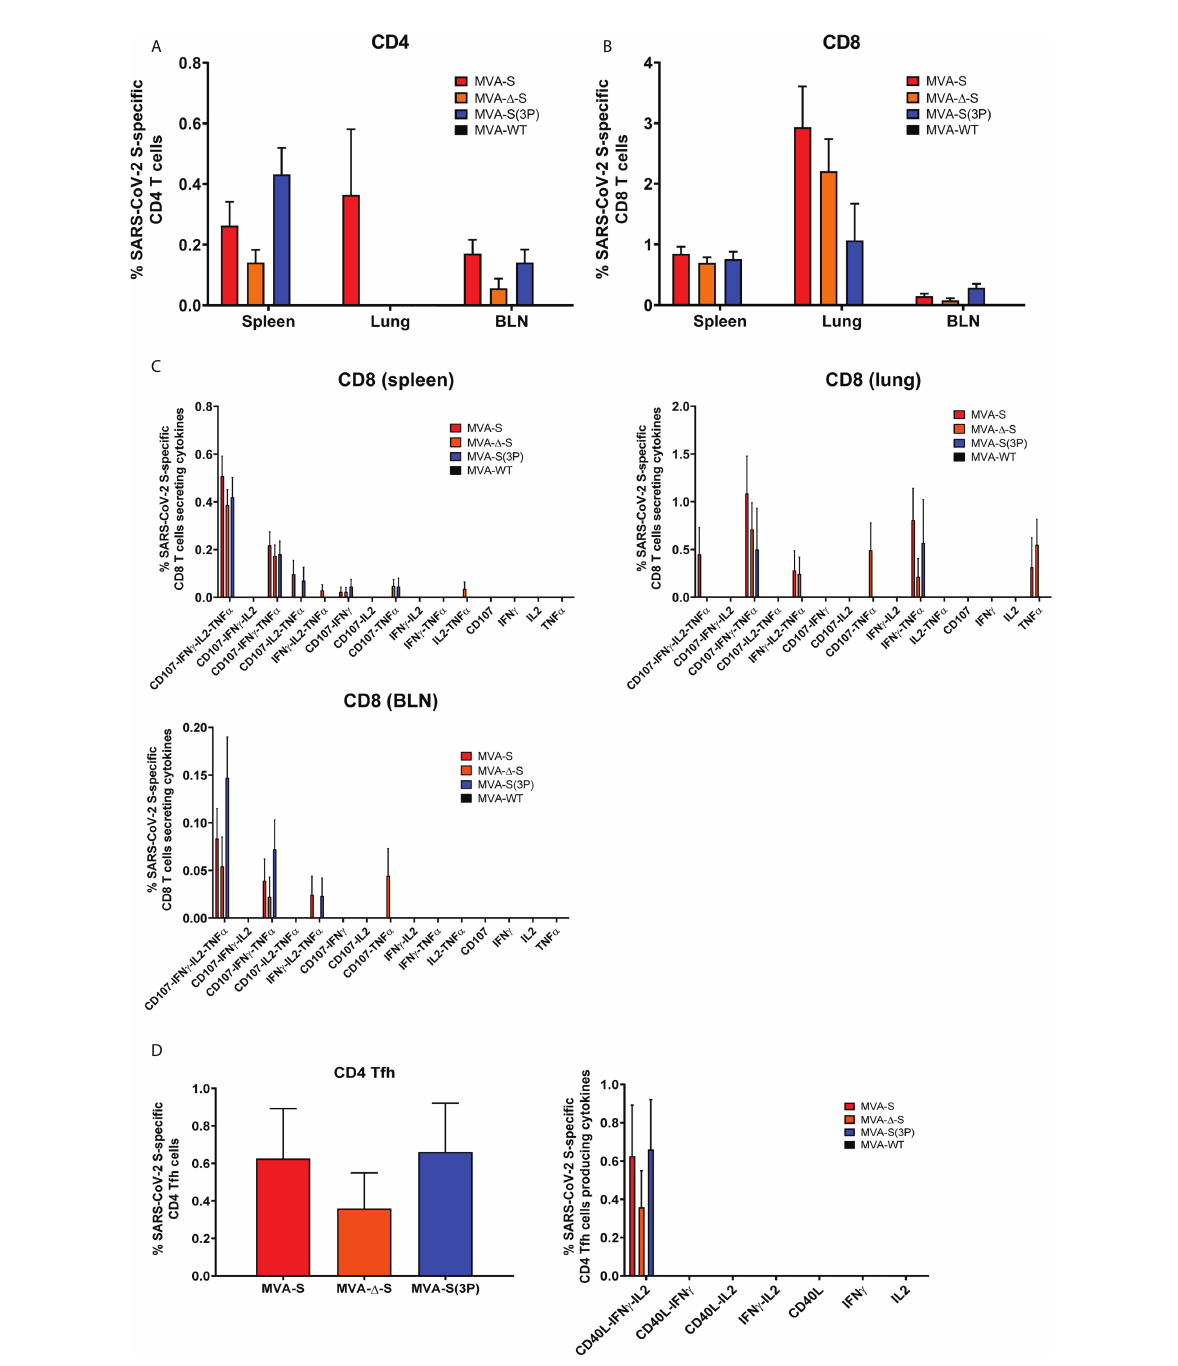
FIGURE 2 SARS-CoV-2-speci fi c T-cellular immune responses elicited in C57BL/6 mice immunized with one IN dose of different MVA-based vaccine candidates against COVID-19. SARS-CoV-2 S-speci fi c T-cellular immune responses were evaluated in spleens, lungs, and bronchial lymph nodes (BLNs) at 14 days postimmunization from C57BL/6 mice immunized with one IN dose of MVA-S, MVA- D -S, or MVA-S(3P). Cell percentages were determined by ICS. (A, B) Magnitude of S-speci fi c CD4 + (A) and CD8 + (B) T-cell immune responses in spleens, lungs, and BLN. Percentages of CD4 + or CD8 + T cells expressing CD107a and/or producing IFN- g and/or TNF- a and/or IL-2 against a mixture of S1 and S2 peptide pools in immunized mice. (C) Polyfunctional pro fi les (based on expression of selected markers CD107a, IFN- g , TNF- a , and IL-2) of total S-speci fi c CD8 + T-cell immune responses directed against a mixture of S1 and S2 peptide pools, in spleen, lungs, and BLN. (D) Magnitude of S-speci fi c CD4 + Tfh cell responses in spleen. Percentages of CD4 + Tfh cells expressing CD40L and/or producing IFN- g and/or IL-21 against a mixture of S protein plus S1 and S2 peptide pools in immunized mice. Polyfunctionality pro fi le is shown on the